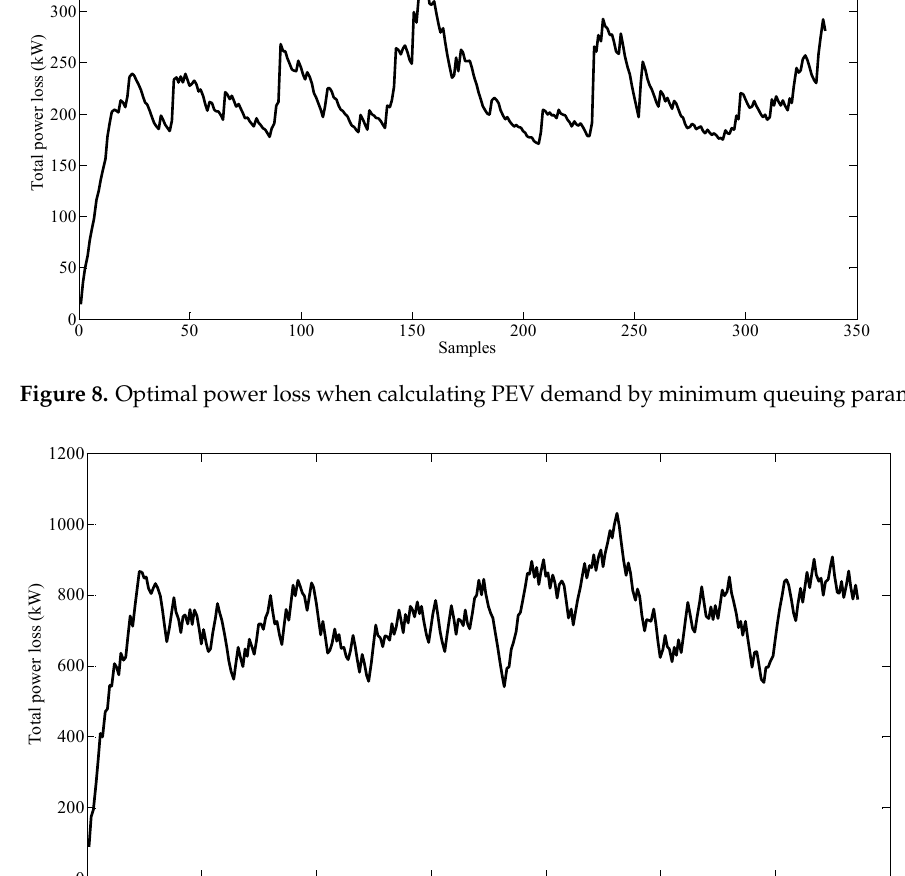
Figure 9. Optimal power loss when calculating PEV demand by average queuing parameters.